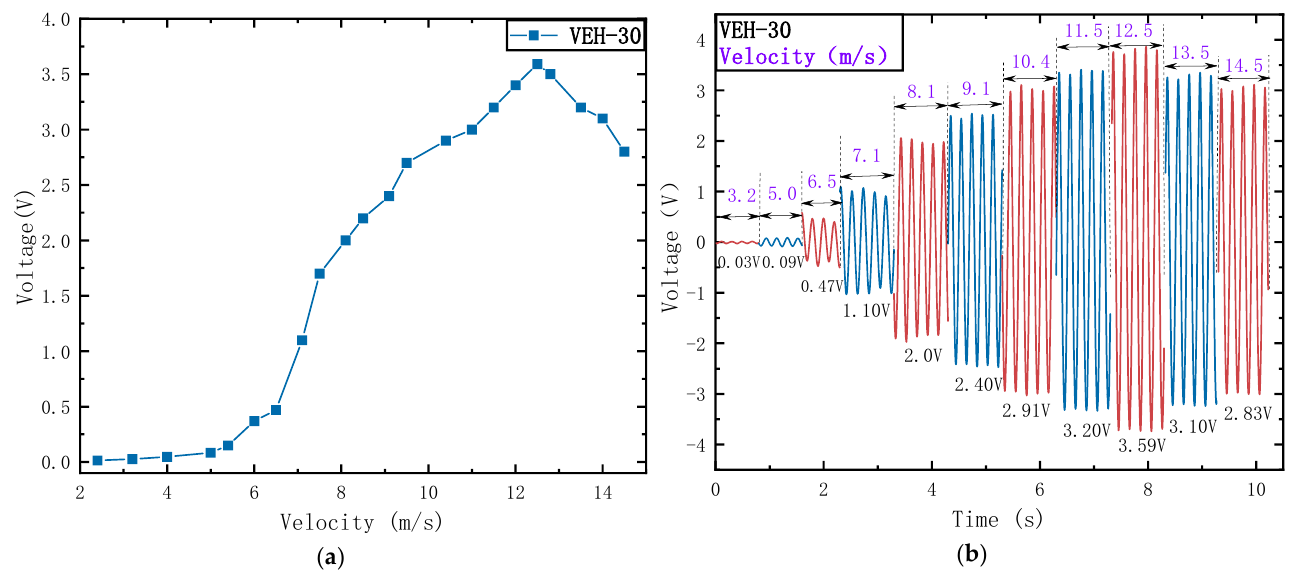
Figure 6. VEH-30 at different wind velocities: ( a ) Output voltage graph; ( b ) Voltage versus time graph.